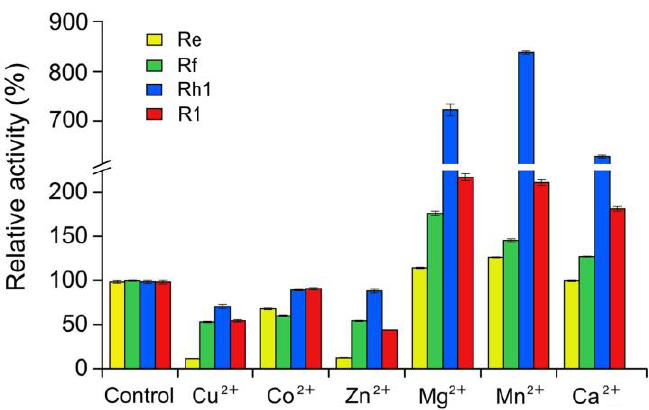
Figure 7. Effect of metal ions on the enzymatic activity of UGT109A1.